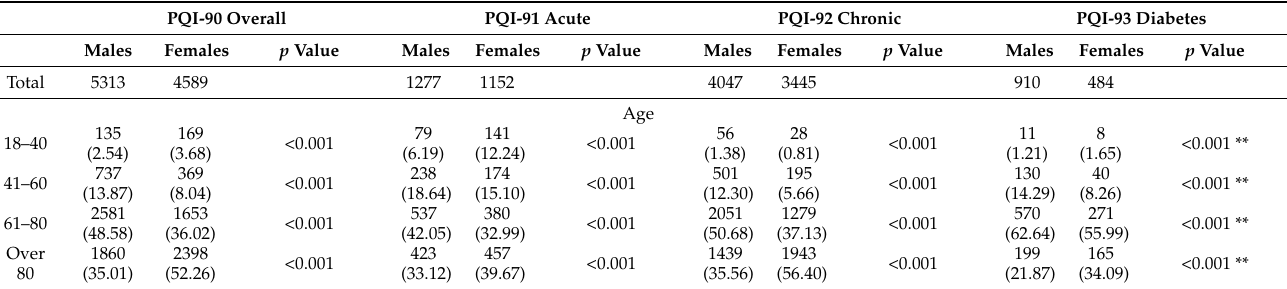
Table 2. Age of the population by gender and by